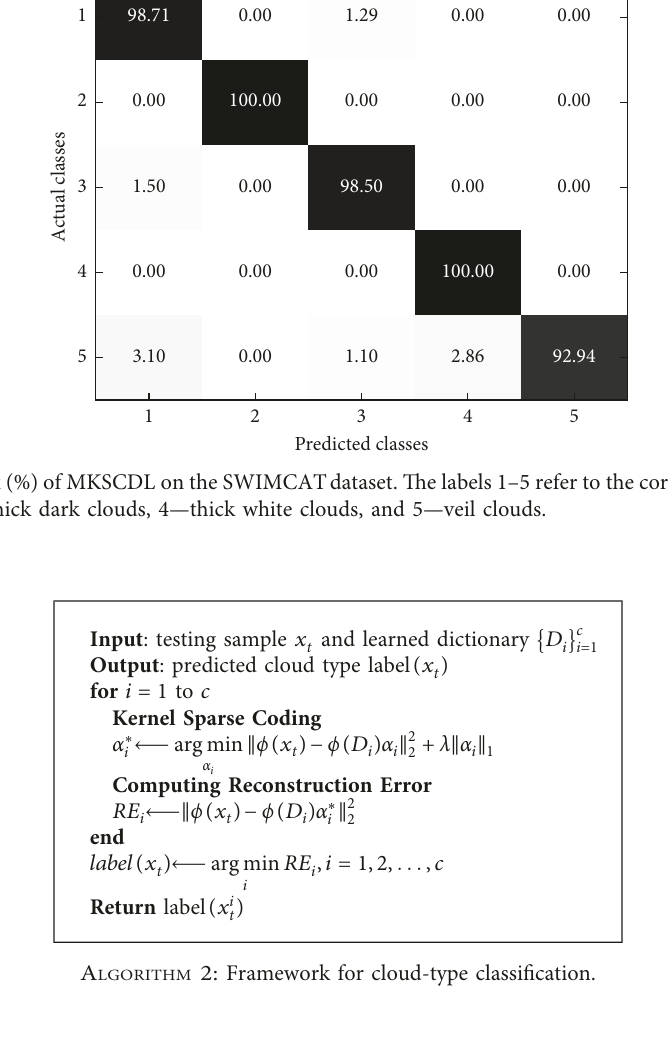
Table 1: Recognition rates of different methods in 10-fold cross validation (%).